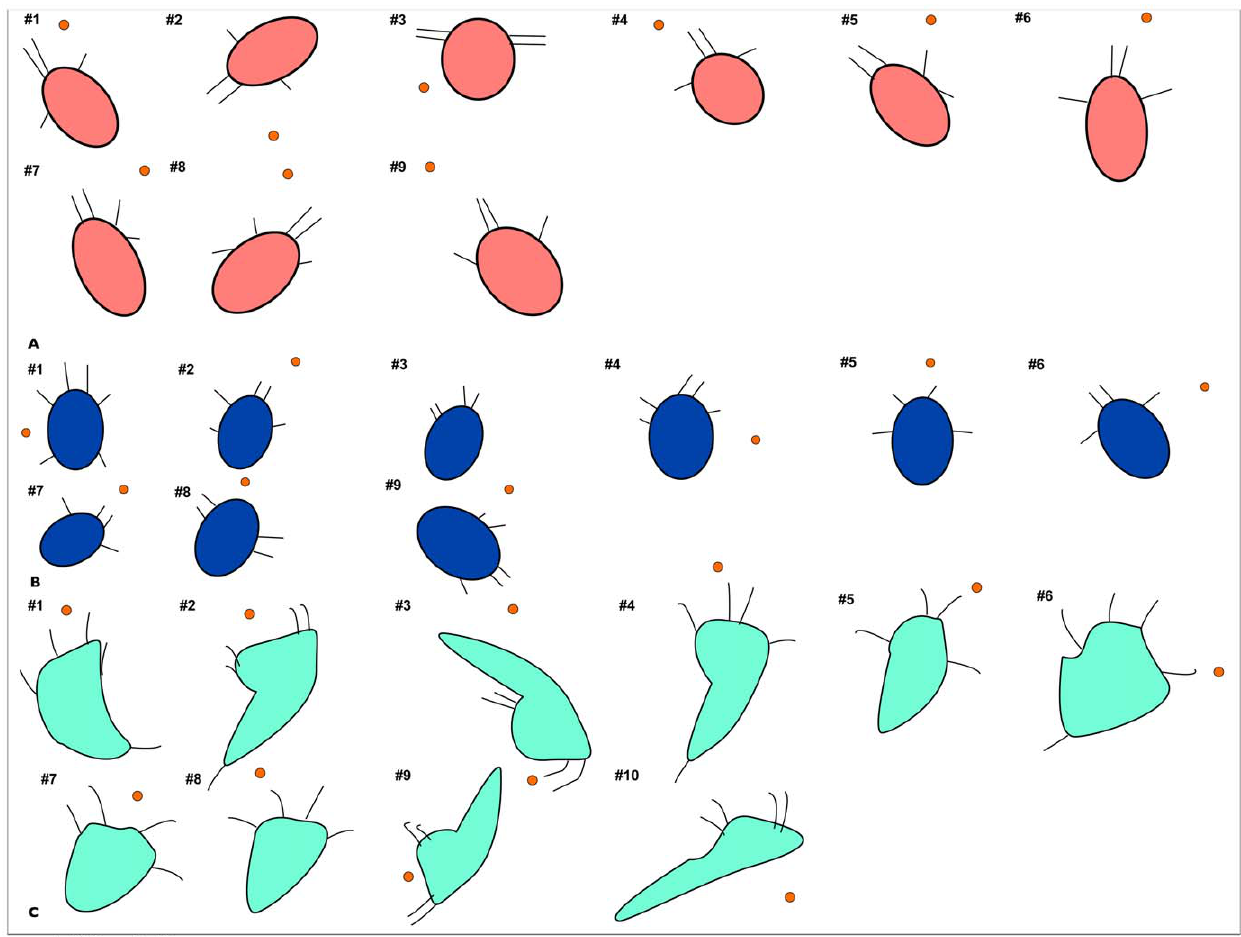
Figure 2. Position and orientation of the nauplii. Schematic drawing of the position and orientation of the nauplii and their prey (represented by small red dots) immediately prior to attack: (A) Acartia tonsa and Rhodomonas salina , (B) Oithona davisae and Oxyrrhis marina , (C) Temora longicornis and R. salina ( Heterocapsa triquetra in # 3 and # 7), not in scale.